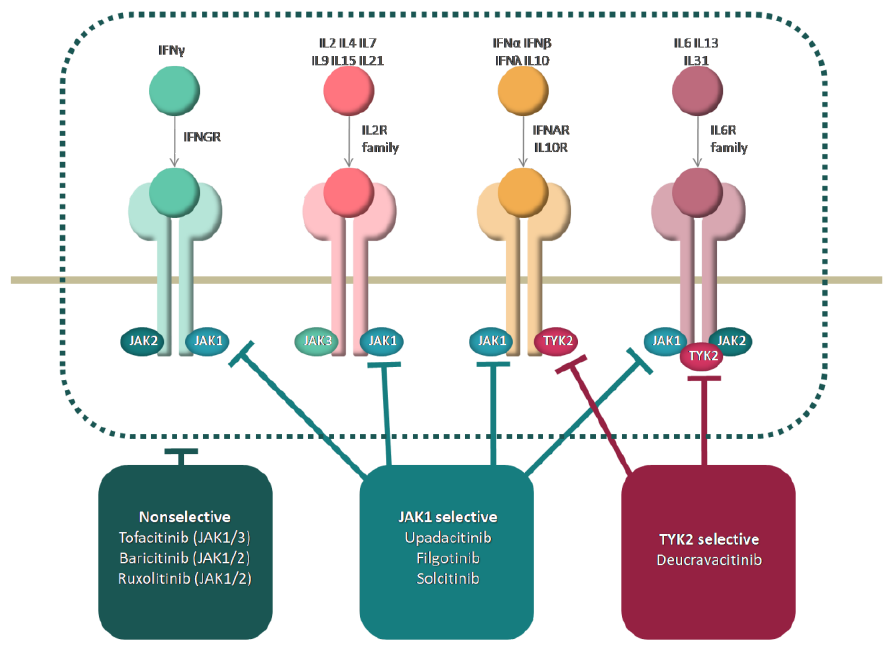
Figure 1. Mechanism of action of JAK inhibitors .